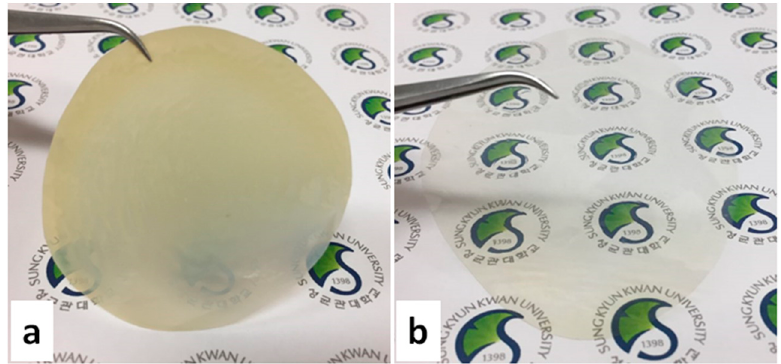
Figure 2. Physical appearance images of ( a ) QPECH/PAEK-API blend and ( b ) cross-linked membranes.